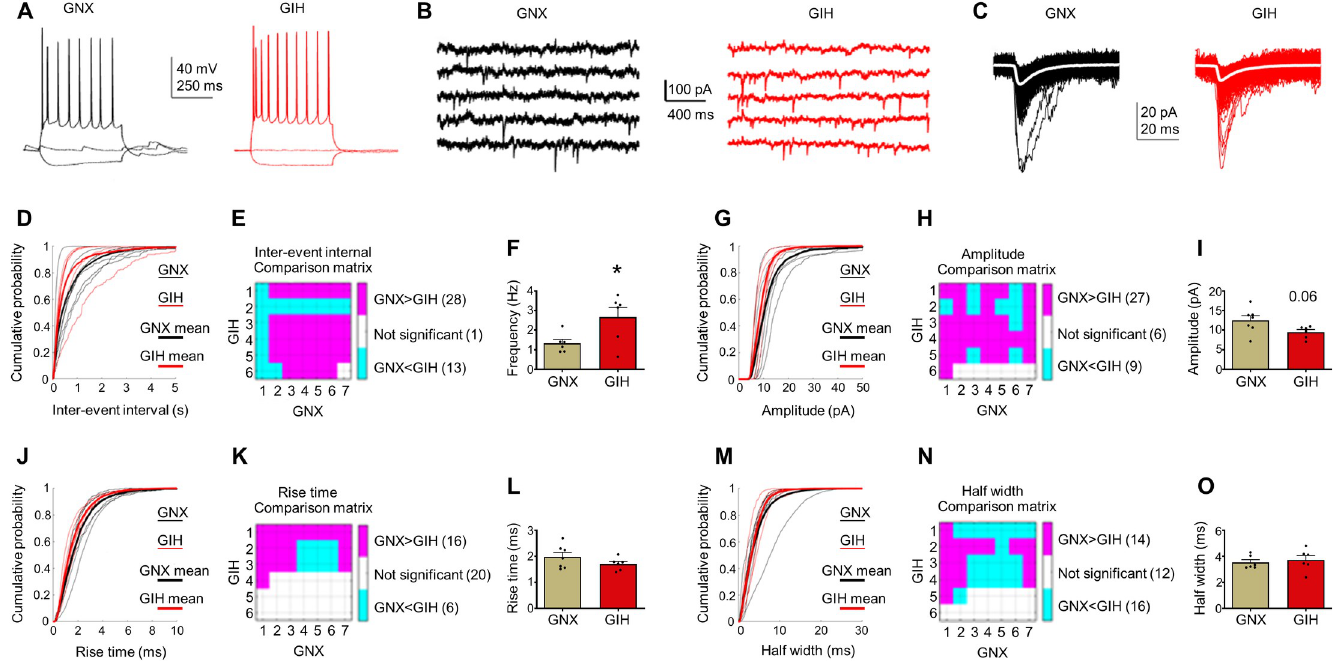
Fig 7. Alterations in AMPA sEPSCs from mPFC layer 2/3 pyramidal neurons of adult male GIH offspring. (A) Firing patterns in response to current injections ( − 100, 0, 280 pA) were used to identify putative pyramidal neurons in GNX and GIH offspring. (B) Examples of continuous voltage clamp traces ( − 60 mV, room temperature) from layer 2/3 mPFC pyramidal neurons in GNX and GIH adult offspring. (C) Detected sEPSCs (black or red) and average (white) from the same cells as in B. (D) Cumulative distributions of sEPSC interevent intervals in adult GNX and GIH offspring. (E) Interevent interval comparison matrix shows differences and their directions for all pairwise comparisons between adult GNX and GIH offspring neurons. (F) Graph shows mean group sEPSC frequency for GNX and GIH offspring neurons [t (df,10) = 2.473, p = 0.033]. n = 6 GNX and 6 GIH cells from 2 rats each (1 Grubbs test extreme outlier in GNX group removed). (G) Cumulative distributions of sEPSC amplitudes in adult GNX and GIH offspring. (H) Amplitude comparison matrix shows differences and their directions for all pairwise comparisons between GNX and GIH offspring neurons. (I) Graph shows mean group sEPSC amplitude for adult GNX and GIH offspring neurons [t (df,11) = 2.052, p = 0.0647]. n = 7 GNX and 6 GIH cells from 2 rats each. (J) Cumulative distributions of sEPSC rise times in adult GNX and GIH offspring. (K) Rise time comparison matrix shows differences and their directions for all pairwise comparisons between GNX and GIH offspring neurons. (L) Mean group sEPSC rise time for adult GNX and GIH offspring neurons [t (df,11) = 1.344, p = 0.2059]. n = 7 GNX and 6 GIH cells from 2 rats each. (M) Cumulative distributions of sEPSC half widths in GNX and GIH offspring. (N) Half width comparison matrix shows differences and their directions for all pairwise comparisons between GNX and GIH offspring neurons.